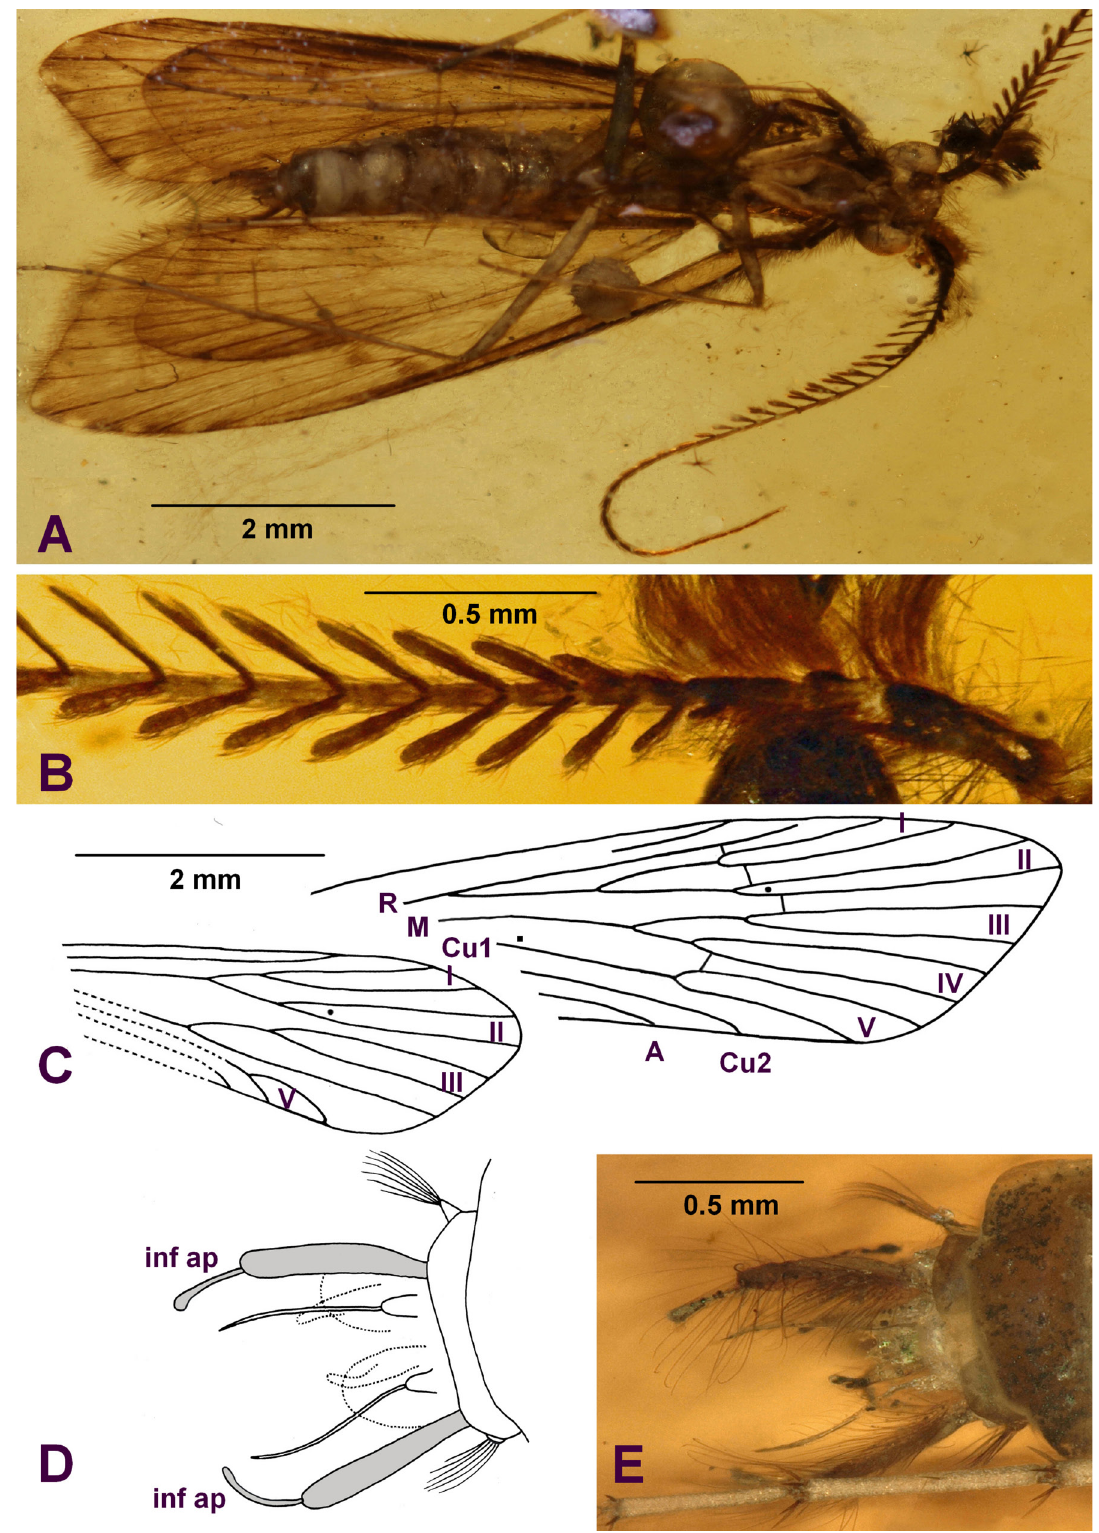
Fig. 5. Bipectinata orientalis sp. nov . (NIGP172206) A . Holotype male in ventral view. B . Bipectinate antennae with scapus, pedicellus and flagellomeres. C . Drawing of fore- and hindwings. D . Drawing of the male genitalia. E . Male genitalia in dorsal